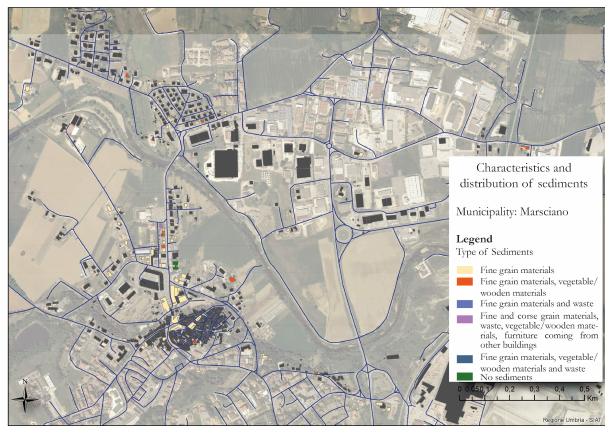
Figure 3. Sediments’ distribution in Marsciano.